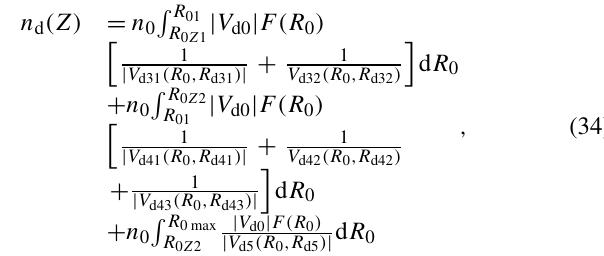
4. R 0 >R 0 Z 2 : ice particles pass through Z only once, and their radius and velocity are R d5 and V d5 ,